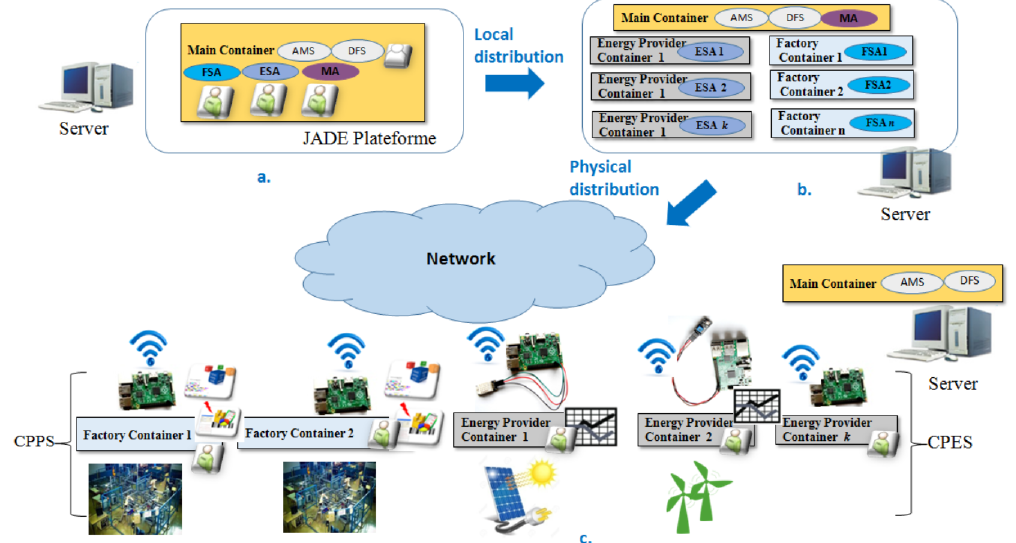
Figure 8. Implementation of EasySched: ( a ) Local distribution in one container, ( b ) Local distribution in different containers, ( c ) Physical distribution in different embedded networked